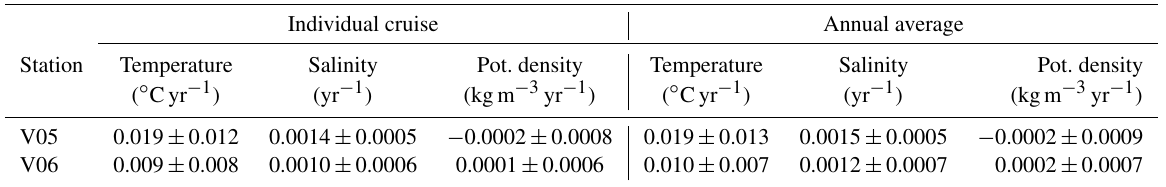
Table 4. Linear trends of average properties of the overflow layer ( σ θ ≥ 27.8kgm − 3 ) at stations V05 (96 occupations) and V06 (94 occu- pations) through the observational period. The table shows both the trend calculated from individual cruises and the trend calculated from annual